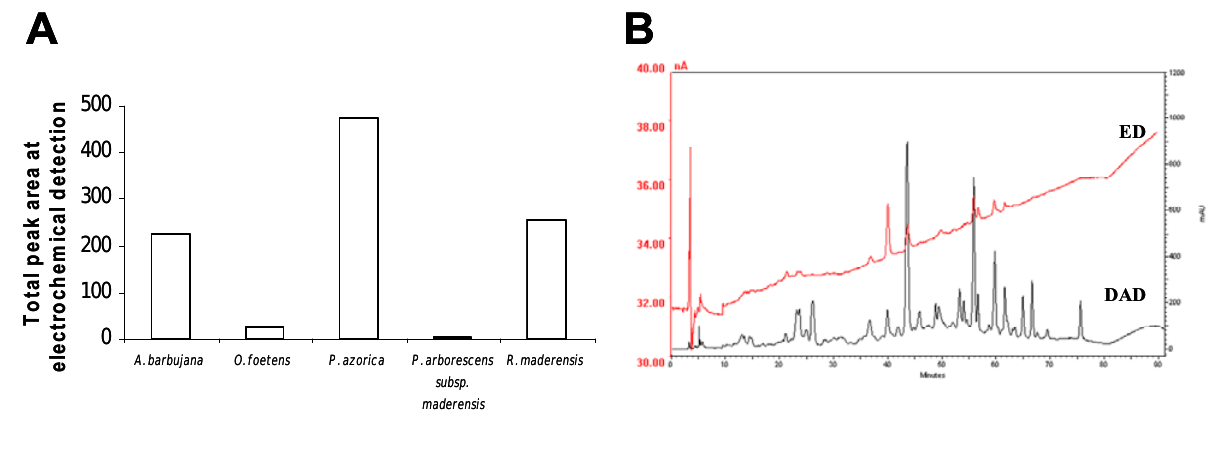
Figure 4. Phytochemical characterization of the five Macaronesia leaf water-ethanol extracts using the diode array (DAD) at 280 nm and the electrochemical detectors (ED) in tandem(-1 V, + 1 V). (A) Total area of the peaks detected electrochemically for the five plant extracts studied; Chromatographic profiles of A. barbuj ana (B); P. azorica (C); R. maderensis (D); Chromatograms at 280 nm and peak identification (E) of A. barbujana (Ab), P. azorica (Pa) and R. made rensis (Rm). Peak identification: 1. Ascorbic acid; 2. Gallic acid; 3. Protocatechuic acid; 4. Neochlorogenic acid; 5. Caffeic acid; 6. Procyanidin B2; 7. Hydroxycinamic acid derivate; 8. Epicatechin; 9. Caffeic acid derivate 1; 10. Procyanidin; 11. Coumaric acid; 12. Rutin; 13. Quercetin/ kaempferol/ myrcetin glucosydes; 14. Caffeic acid derivate 2; 15. Apigenin; 16.